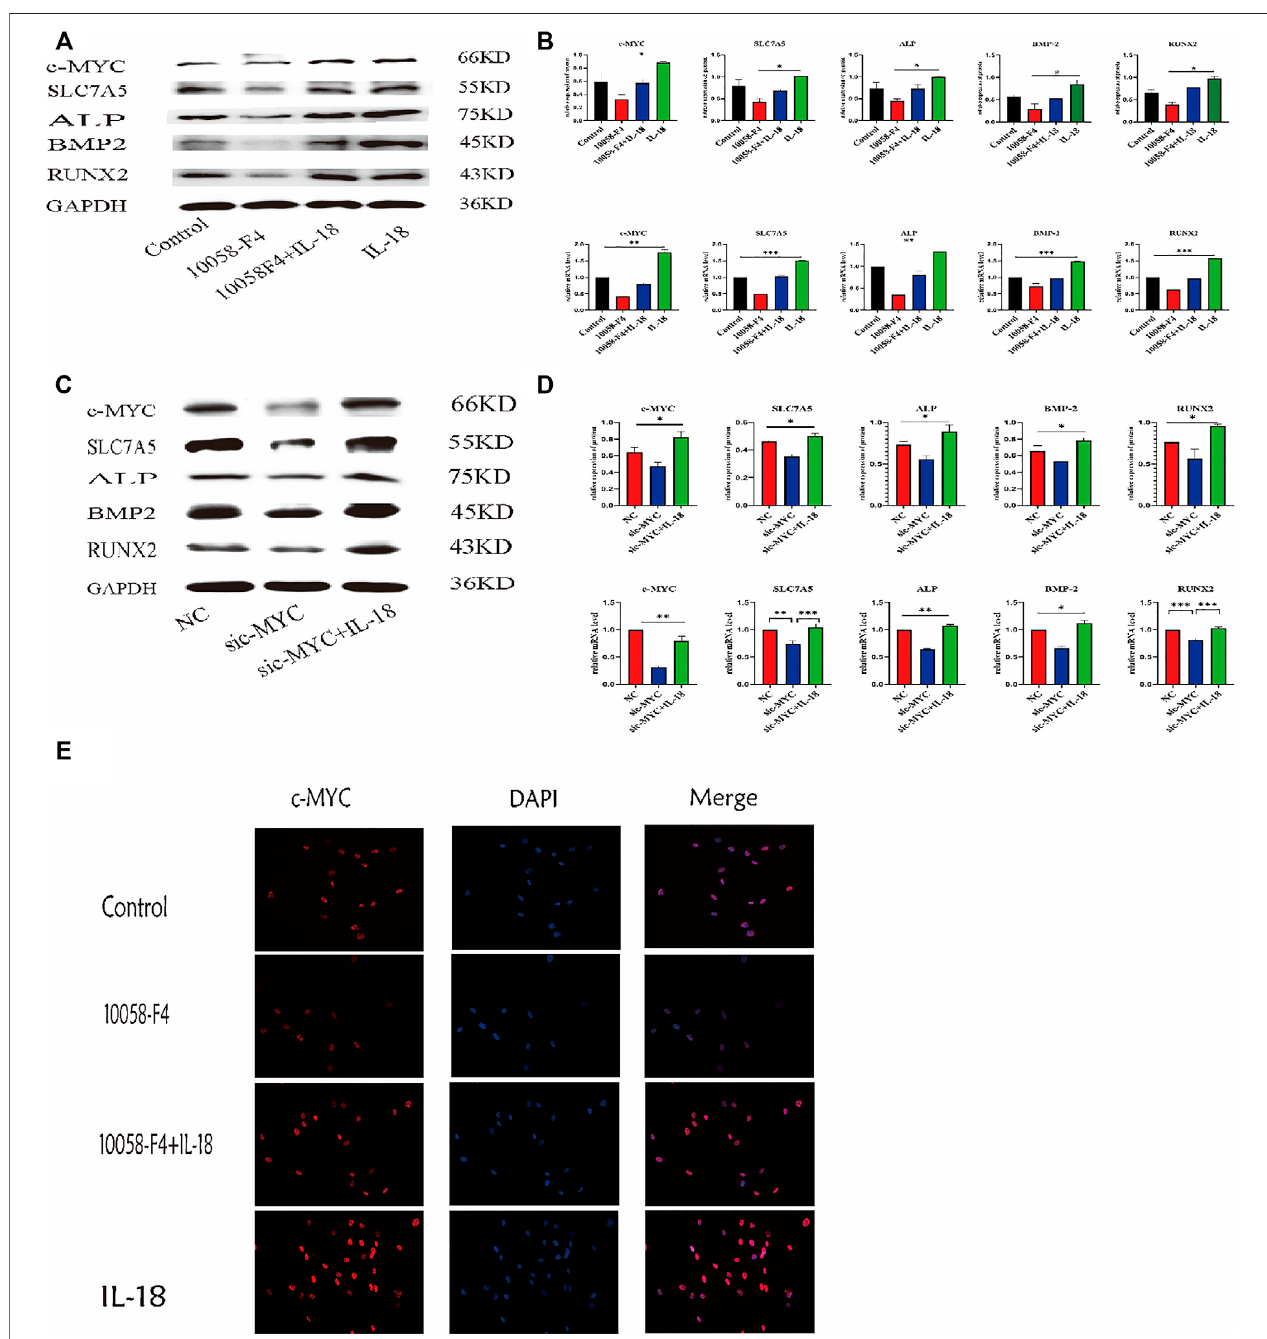
FIGURE 6 | Inhibition of c-MYC can reduce the bone-forming ability of HBMSC induced by IL-18. The cells were treated with 10058-F4 (5 μ M) for 72 h, and then with 100 ng/ml IL-18 for 12 h western blotting and q-PCR experiments were conducted to detect osteogenic factors and the protein and mRNA expression of c-MYC andSLC7A5,ALP,BMP2,RUNX2;GAPDHwasusedasaninternalcontrol (A,B) .Cellsweretransfectedfor48 handthentreatedwith100 ng/mlIL-18for12 h,mRNA levels of SLC7A5, c-MYC and osteoblast-speci fi c factors were quantied by qRT-PCR, Cells were transfected for 72 h and then treated with 100 ng/ml IL-18 for 12 handthenwesternblottingexperimentswereconductedtoevaluatetheexpressionofosteoblast-speci fi cfactors,aswellasc-MYCandSLC7A5;GAPDHwasused as an internal control (C, D) . After treatment with 10058-F4 (5 μ M) for 72 h and 100 ng/ml IL-18 for 12 h, immuno fl uorescence staining was used to observe c-MYC protein levels (E) . Data expressed as the mean ± standard deviation (SD). Experiments were repeated three times.* p < 0.05, ** p < 0.01, *** p < 0.001 (multiple comparisons use one-way ANOVA with a subsequent Bonferroni post-hoc test).